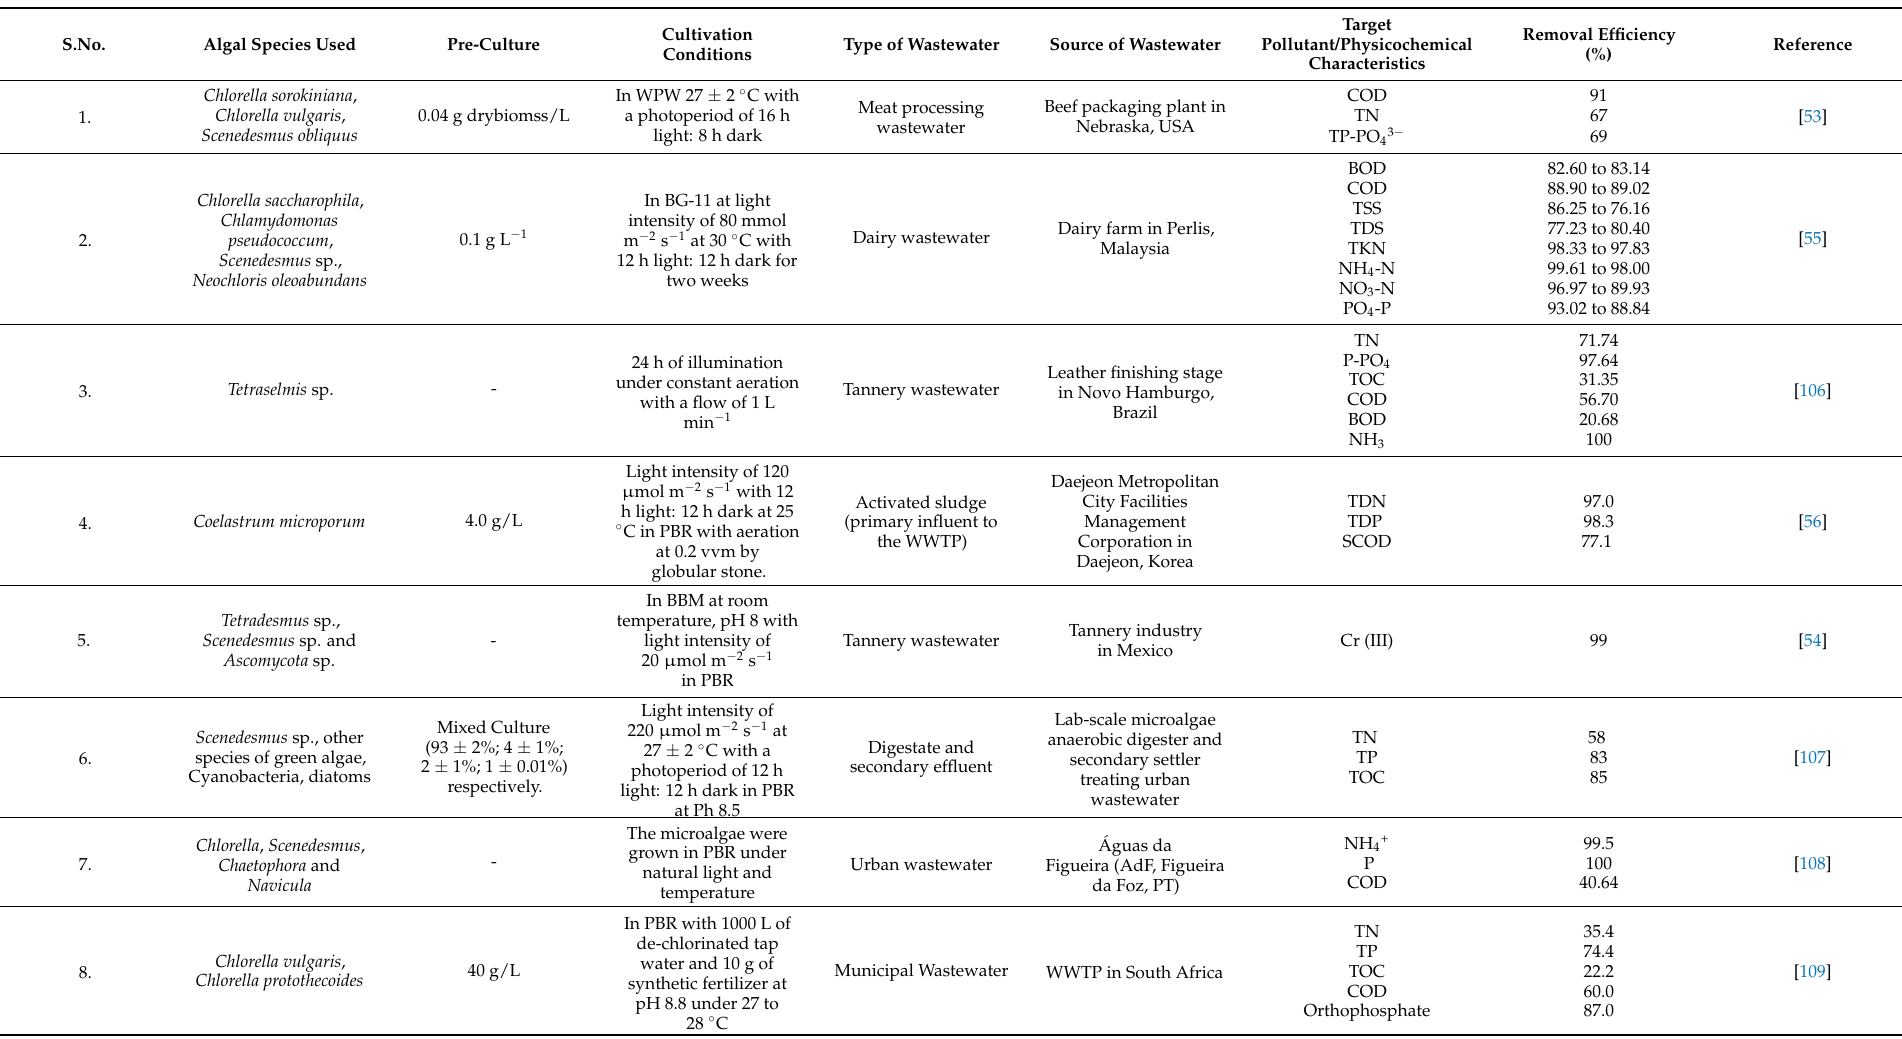
Table 1. Utilization of algae–algae consortium for wastewater